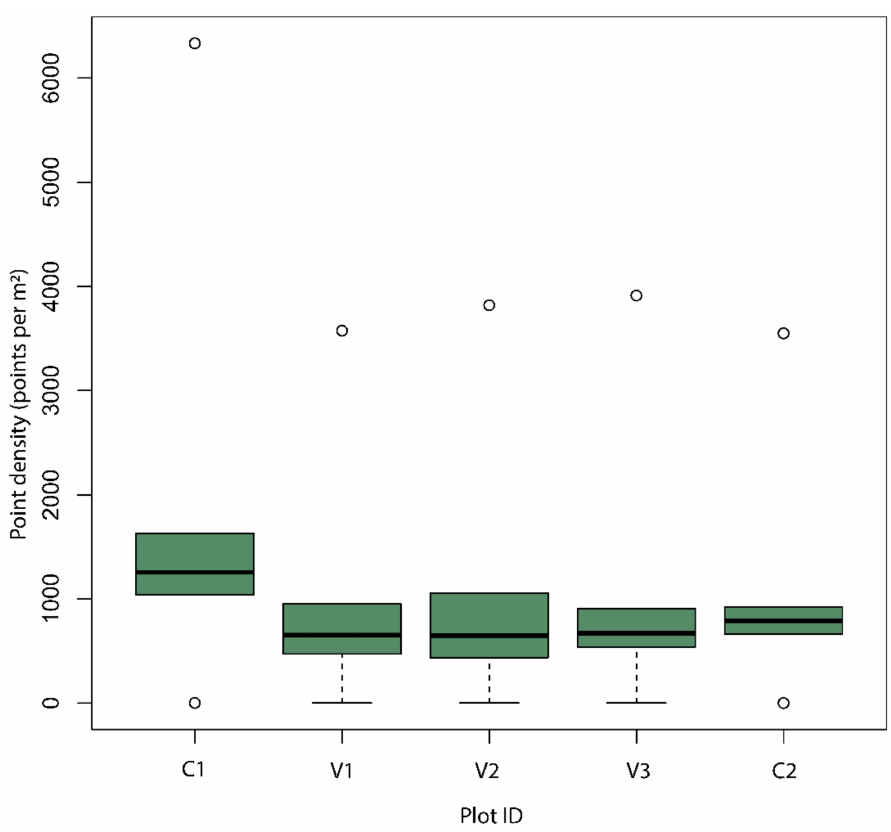
Figure A1. Boxplots of the point density within the five one-hectare plots prior to